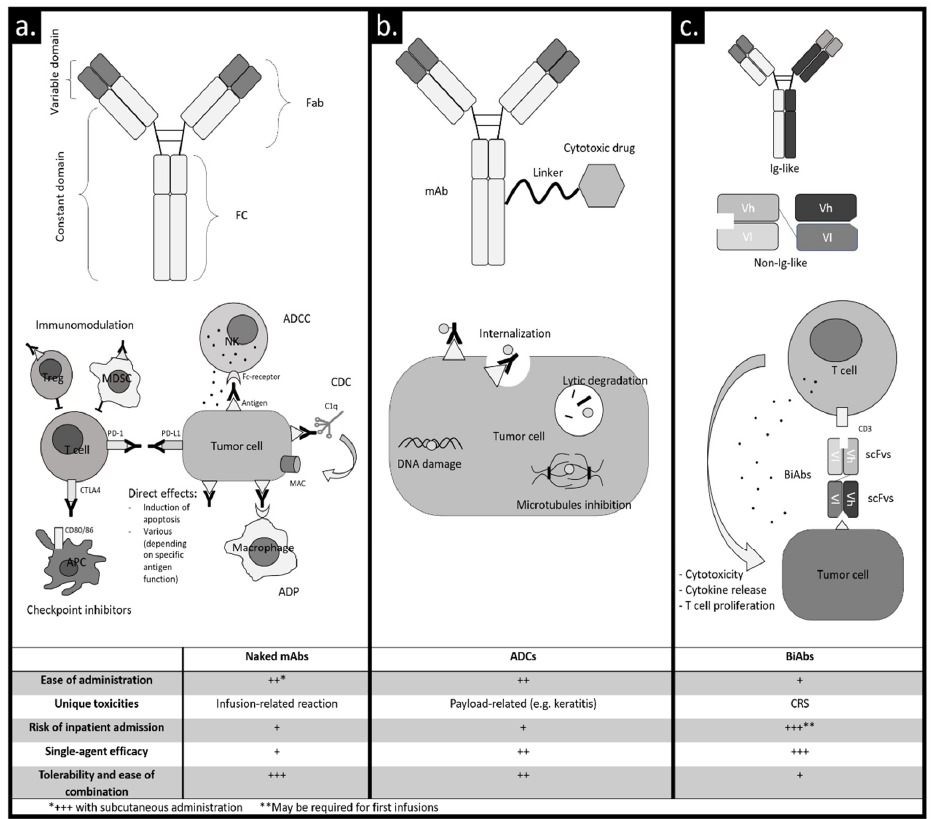
Figure 1. Monoclonal antibodies: types and mechanisms of action. ( a ) Naked monoclonal antibody (mAb). Antibody-dependent cellular cytotoxicity (ADCC): natural killer cell (NK) binds to the Fc region via the Fc-receptor and releases lytic factors such as perforin and granzymes. Complement-dependent cytotoxicity (CDC): interaction between the Fc region and protein C1q activates the classic complement pathway that results in the formation of membrane attack complex (MAC) and cell lysis. Antibody-dependent phagocytosis (ADP): the binding of macrophages induces activation of phagocytosis. Direct effects: induction of apoptosis directly or through cross-linking; effects depending on specific antigen functions (e.g., inhibition of intracellular signaling, blocking of enzymatic functions). Checkpoint inhibitors: blockade of programmed cell death protein 1 (PD-1) or cytotoxic T-lymphocyte antigen 4 (CTLA-4) preventing immune response suppression. Immunomodulation: interaction of mAb with stroma cells, which inhibit T cell activation restoring the immune response against neoplastic cells. ( b ) Antibody–drug conjugate. Upon antibody binding to the target, a cytotoxic payload is released in the target cell. ( c ) Bispecific monoclonal antibodies. Ig-like: two binding sites with di ff erent specificity and an Fc region that binds to the Fc-receptor. Non-Ig-like: two di ff erent single-chain variable fragments (variable regions comprised only of the variable regions of the heavy and light chains). Bispecific monoclonal antibodies usually bind a tumor antigen and an immune e ff ector antigen (e.g., CD3 on the T-cell surface), in order to activate the immune cells against the neoplastic cell. Abbreviations : +/++/+++, low/moderate/high; Fab, fragment antigen binding; FC, fragment crystallizable region; Treg, regulatory T cell; MDSC, myeloid-derived suppressor cell; NK, natural killer cell; ADCC, antibody-dependent cellular cytotoxicity; CDC, complement-dependent cytotoxicity; MAC, membrane attack complex; ADP, antibody-dependent phagocytosis; APC, antigen-presenting cell; ADCs, antibody–drug conjugates; BiAbs, bispecific antibodies; CTLA-4, cytotoxic T-lymphocyte antigen 4; PD-1, programmed cell death protein 1; PD-L1, programmed death ligand 1; di-scFv, bivalent single-chain variable fragment; scFv, single-chain variable fragment; CRS: cytokine release syndrome; Ig,